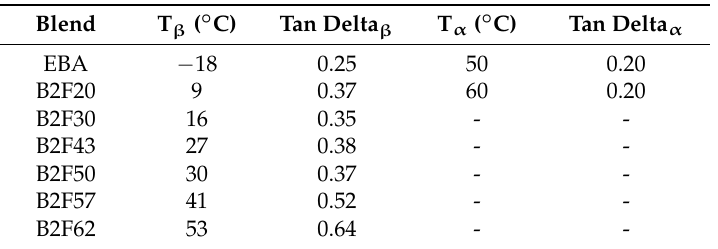
Figure 7. Variation of tan delta as a function of the temperature for EBA copolymer and EBA copolymer + ECH resin blends. Dynamic mechanical thermal analysis (DMA) experiments. Table 4. Values of maximum tan delta and temperature of the structural relaxations in the EBA copolymer and EBA copolymer + ECH resin blends. DMA experiments.